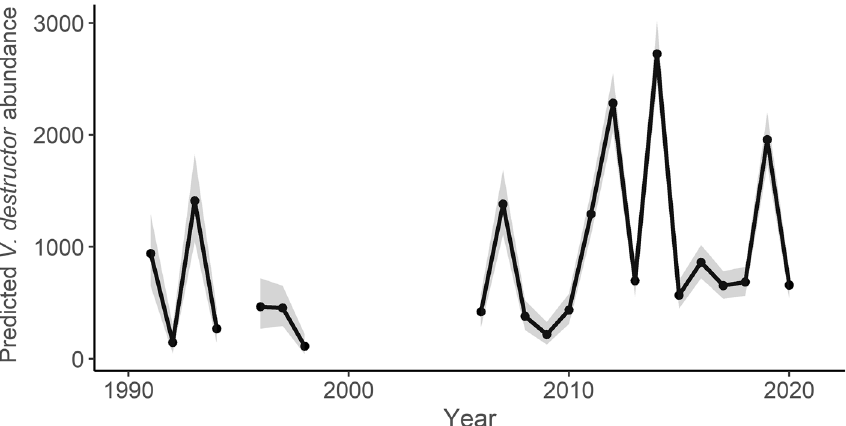
Figure 1. Predicted interannual variation in the V. destructor abundance. Estimates of the baseline model for the random effect of the year were used. Shaded areas indicate standard errors of the